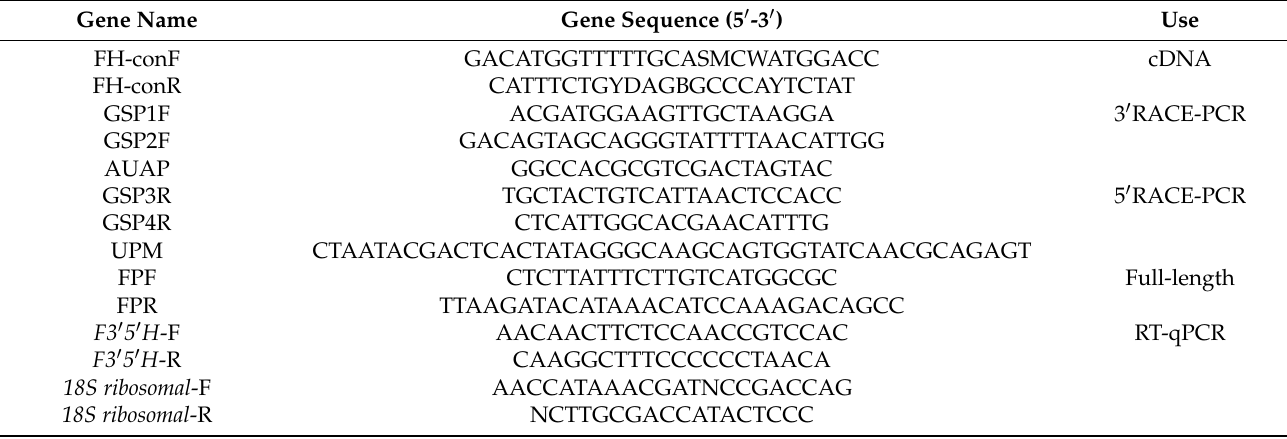
Table 2. Primers used for cDNA cloning and RT-PCR